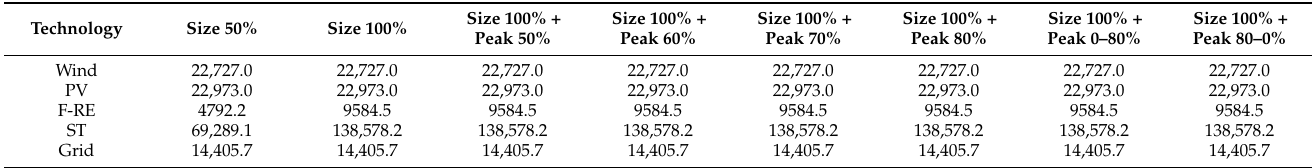
Table A18. Installed capacity in kW capacity of balancing technology scenarios including peak shaving.